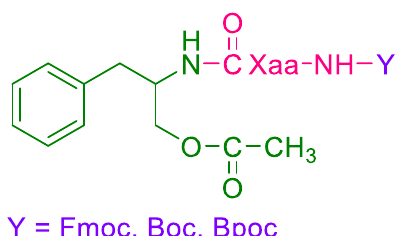
Figure 102. Aurantiamide acetate derivatives with amino acids/peptides.